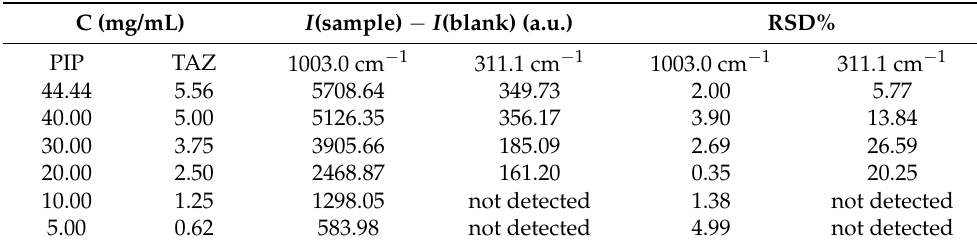
Table 8. Mean peak height values I1003(sample) − I1003(blank) and I311(sample) − I311(blank) and re- spective relative standard deviation (RSD) values corresponding to the three measurements obtained from the samples after they had been placed in the drip chamber of the IV